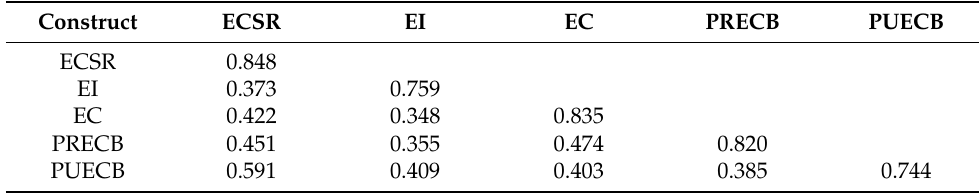
Table 3. Discriminant validity assessment.